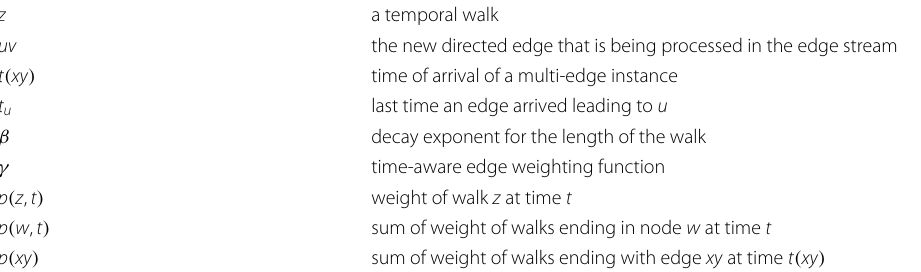
Table 1 Notations used in the StreamWalk algorithm